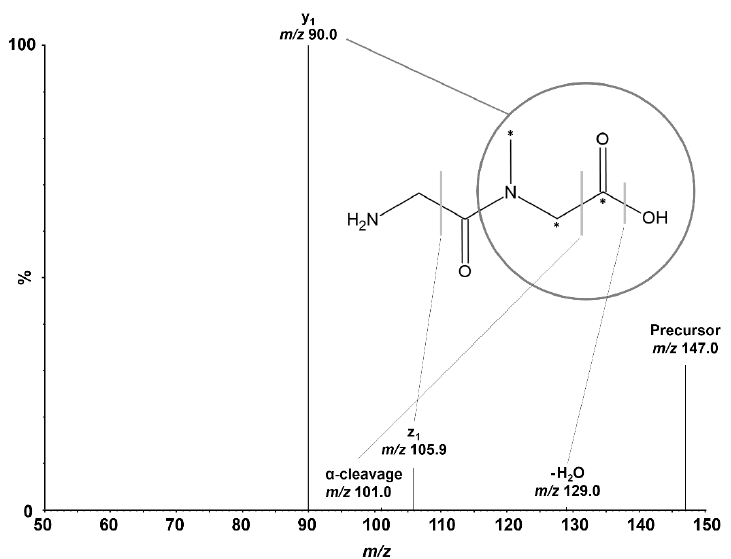
Figure 1. Product ion spectrum of Gly-Sar at a collision energy of 10 V. The structure of Gly-Sar with the positions of the isotopic label in the internal standard marked with asterisks is also depicted. The four investigated dissociation locations are marked by gray bars or a circle, with the circle showing the monitored y 1 -fragment. Gly-Sar was chromatographically separated from endogenous substances on a Wa- ters Cortecs HILIC UPLC ® column (90 Å , 1.6 µm, 2.1 × 50 mm) using isocratic elution at a composition of 16% aqueous eluent and 84% ACN eluent, which was most efficient in separating endogenous interferences (Figure 2). The method gave reproducible retention times and peak shapes with a width at baseline of 24 s. Representative UPLC chromato- grams of cell homogenates with varying Gly-Sar concentrations (blank sample, blank sam- ple spiked with IS, LLOQ, mid QC, and a study sample after 10 min incubation with 20 µM Gly-Sar and 1 mM losartan) are presented in Figure 2. Figure 2. Representative UPLC-MS/MS chromatograms of Gly-Sar in cell lysates. Gly-Sar transition is shown on the left (black filling), and the IS transition is shown on the right (gray filling). Intensities were normalized to the highest signal in the current run: (A) blank sample; (B) blank lysate with added IS; (C) sample at LLOQ concentration; (D) sample at mid